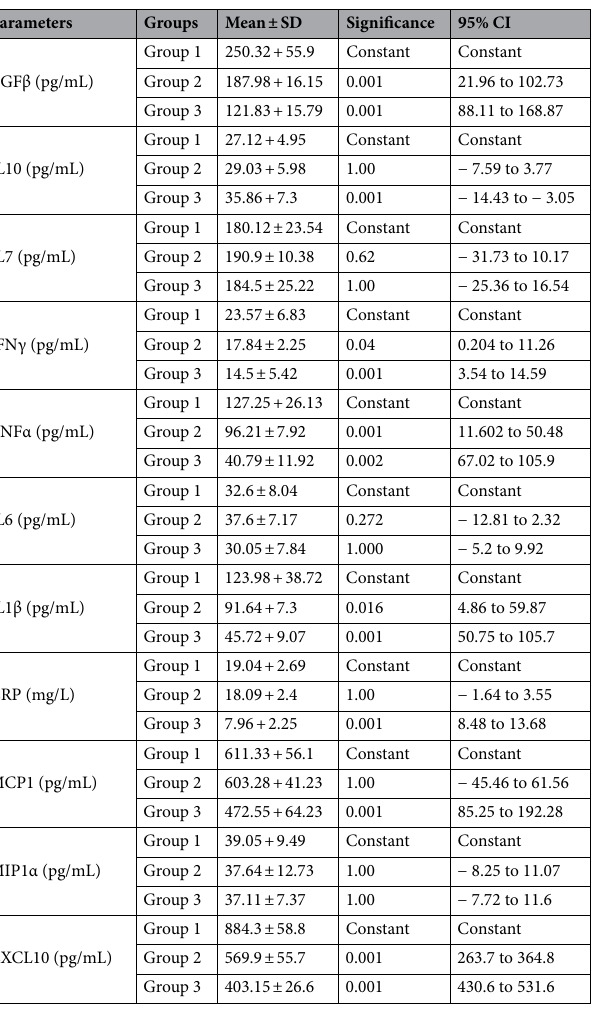
Table 2. A comparative analysis of the different immunological parameters of the patients measured at the time of admission, differentiating Group 1 (N = 26) from Group 2 (N = 25) and Group 3 (N = 25). Mean ± SD values were calculated and one way ANOVA was performed using Bonferroni method (Post-hoc analysis) for comparing the mean values of each group with respect to that of Group